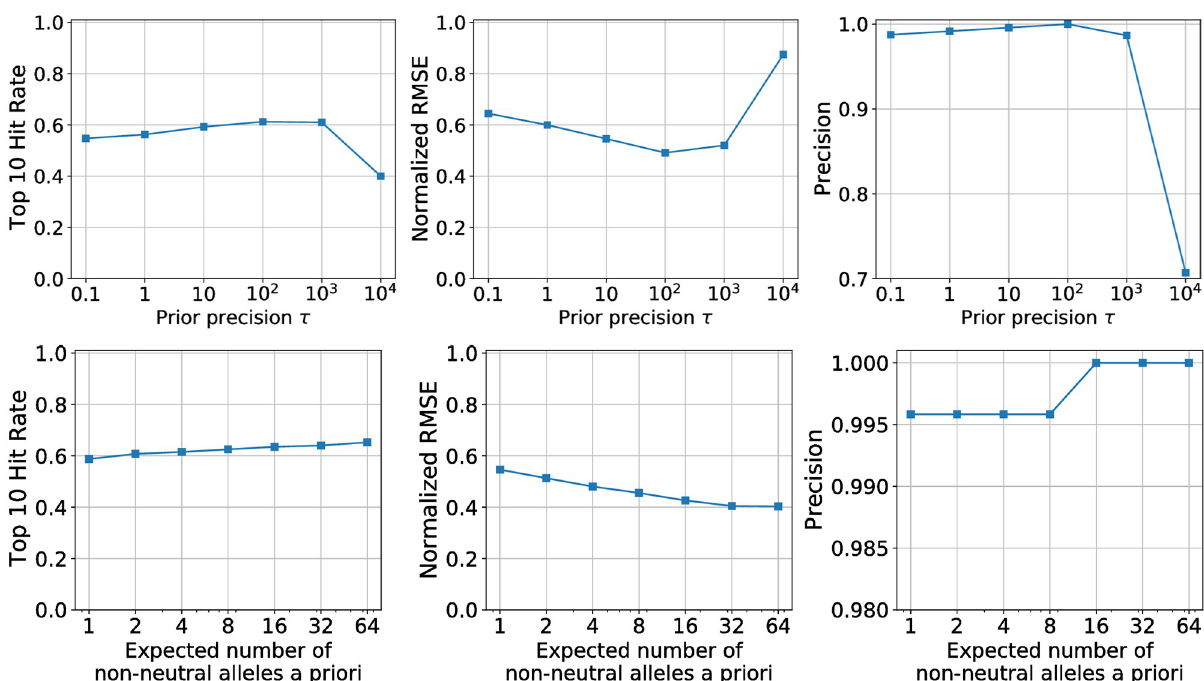
Fig 4. BVAS hyperparameter sensitivity. We explore the extent to which BVAS performance is sensitive to its two hyperparameters, namely τ and S = hA , using the simulated data described in Sec. 3.1. We simulate data for N R = 30 regions and A = 3000 alleles and generate 40 datasets. See Sec. 3.3 for discussion.